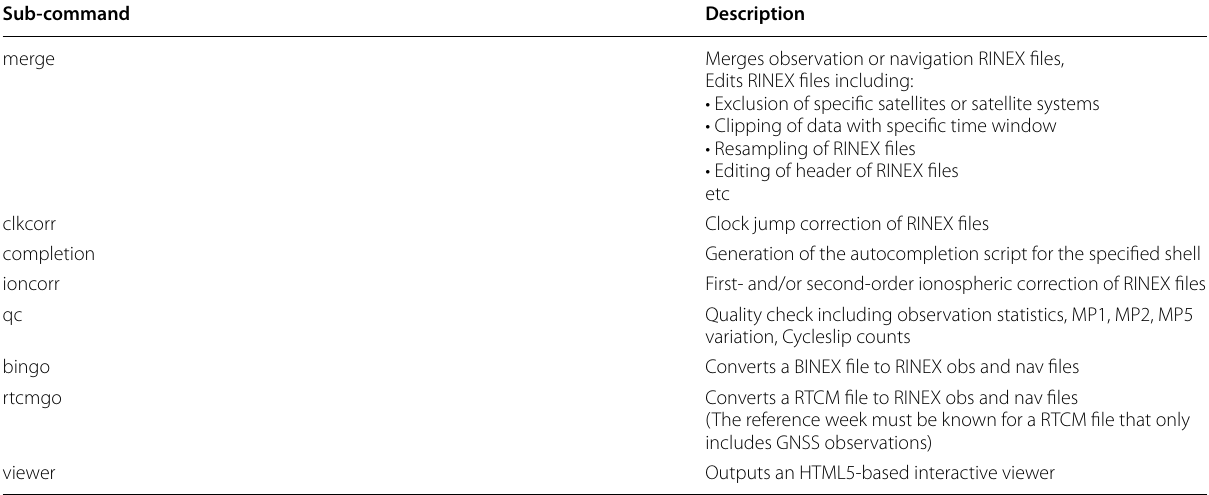
Table 1 Main features of the RINGO software